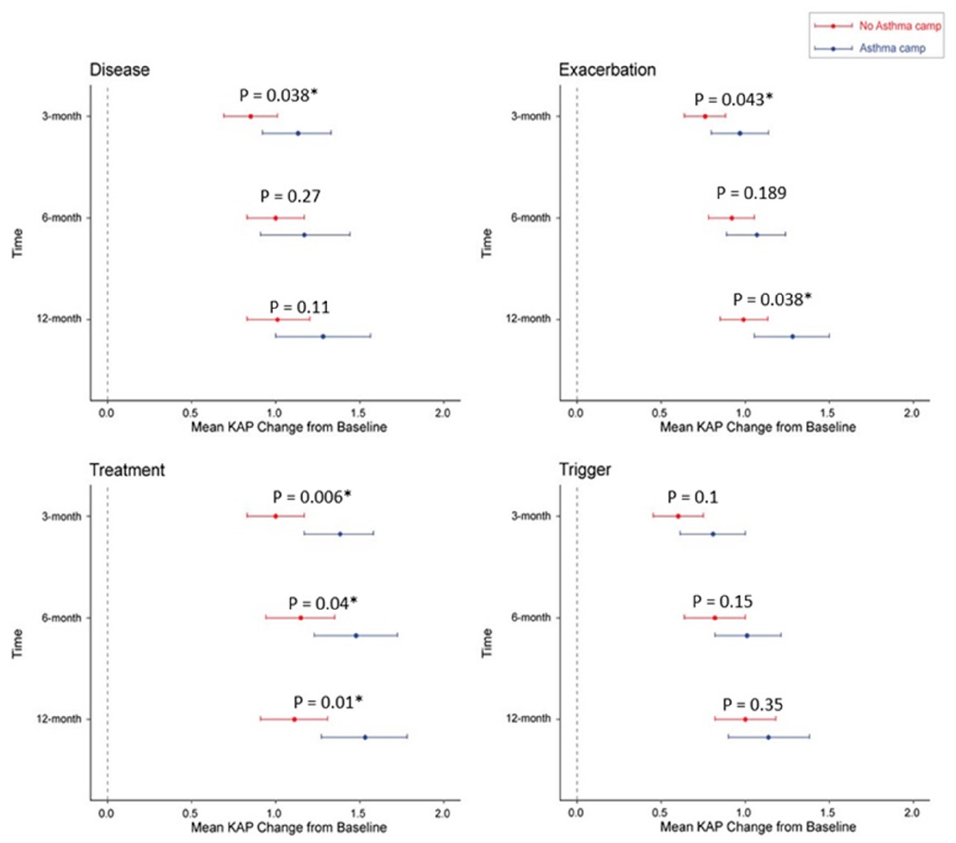
Figure 1. Outcome of KAP score for children who did/did not attend an asthma camp at each visit. KAP; knowledge, attitudes, and practice survey. The asterisk (*) indicates significant difference between two groups. Table 3. Outcome of mean KAP score at baseline and 3 month visit.